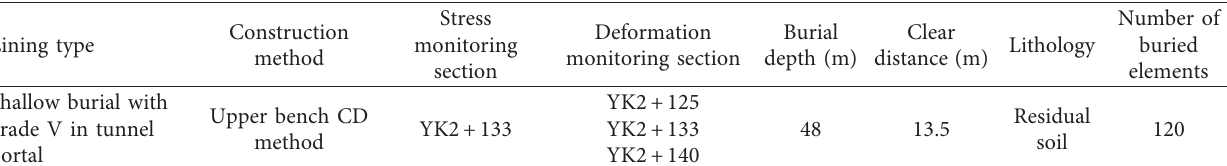
Table 4: Field monitoring